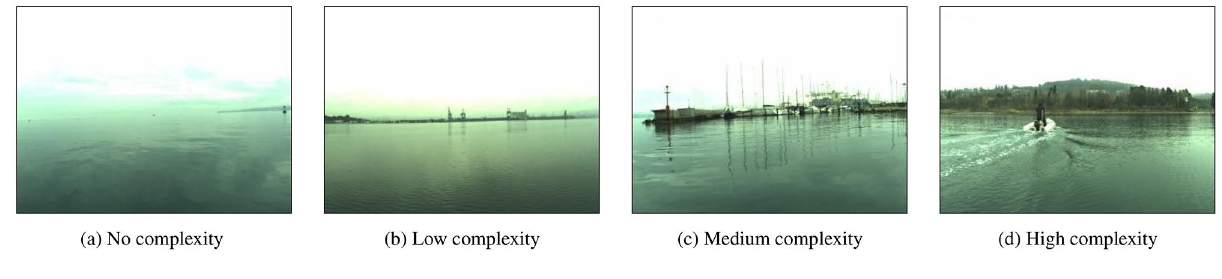
Figure 2. Examples of levels of